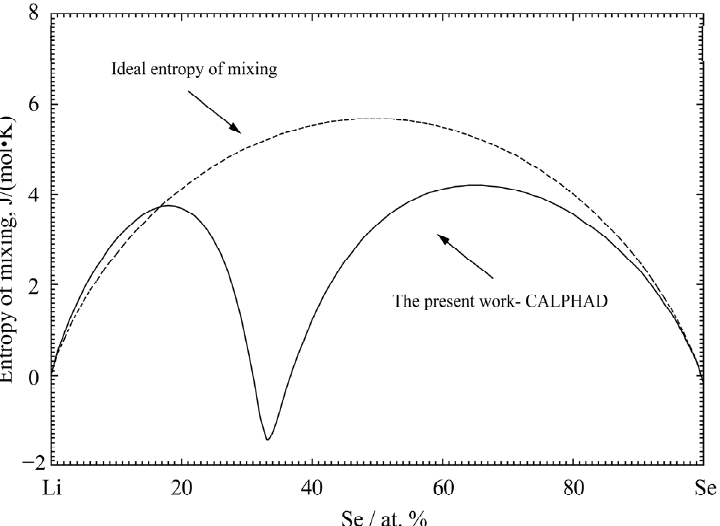
Figure 5. The calculated entropy of mixing for the liquid phase of the Li − Se binary system at 1400 °C.